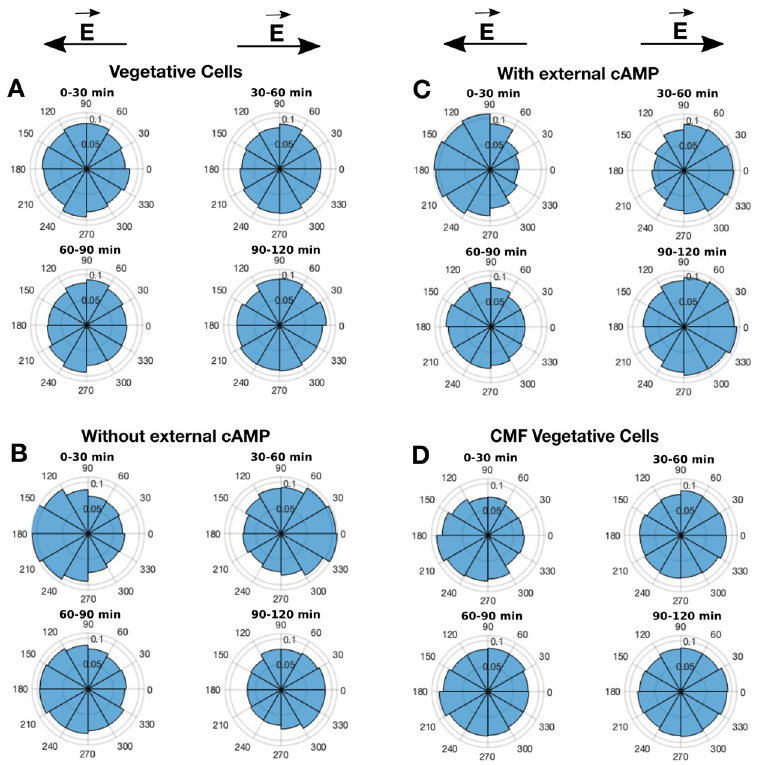
Fig 6. Polar histograms of the propagation angle distribution. Polar histograms of the propagation angle distribution for vegetative cells (A), briefly starved cells in a shaking culture without (B) and with (C) external cAMP pulses, and conditioned vegetative cells (D). Cell motion is biased towards the cathode with θ = 180˚ in the first 30 min and θ = 0˚ or 360˚ when the polarisation of the electric field has been reversed. The histograms represents the distribution of the propagation angle θ 2 [0˚, 360˚] of each time step with respect to the electric field lines pointing towards the cathode. Every histogram resulted by the analysis of 100—300 cells from three different experiments.